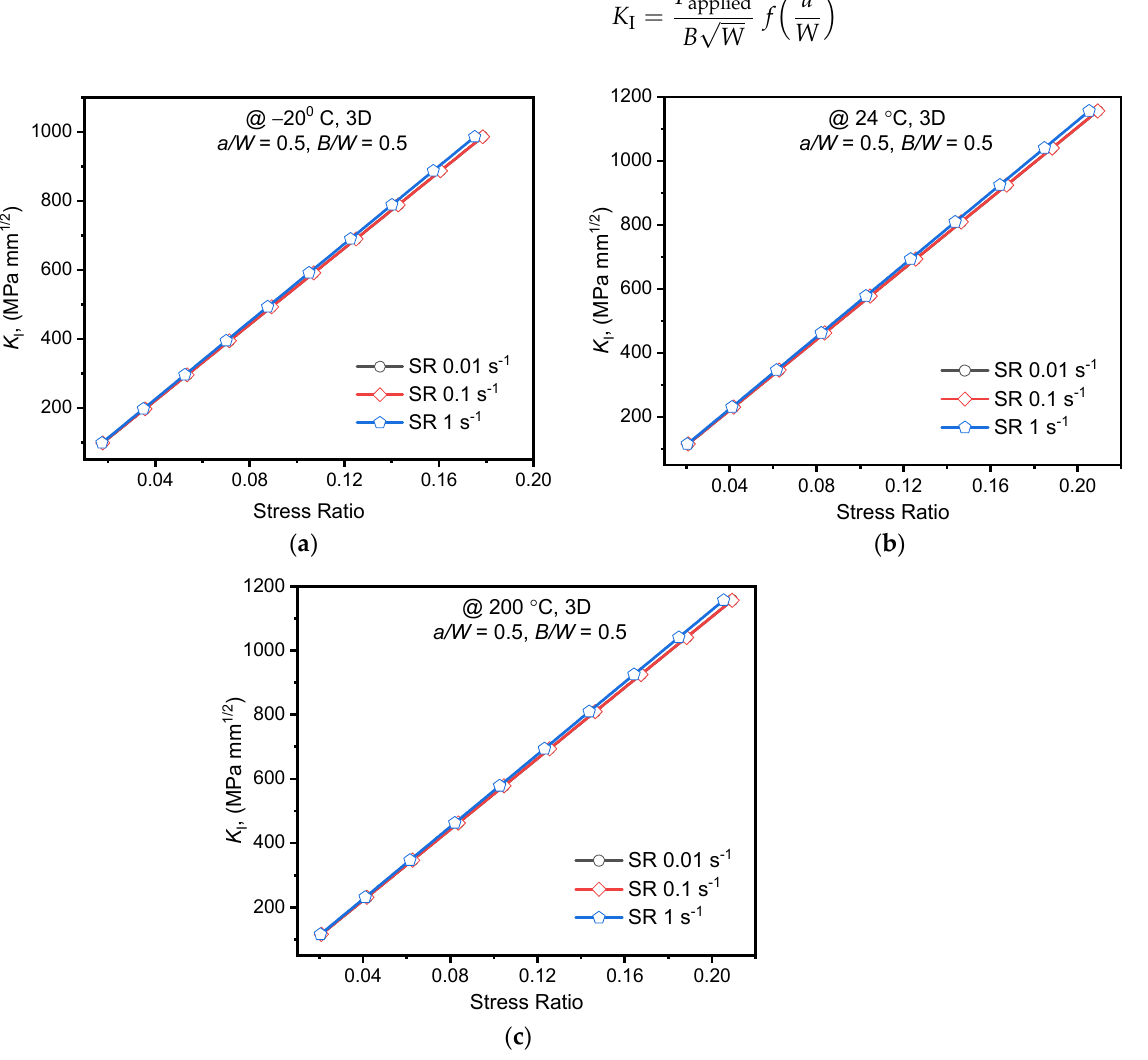
Figure 7. K I at specimen thickness center obtained using FEA for different strain rates vs. Stress ratio ( a ) @ − 20 °C; ( b ) 24 °C; ( c ) 200 °C.